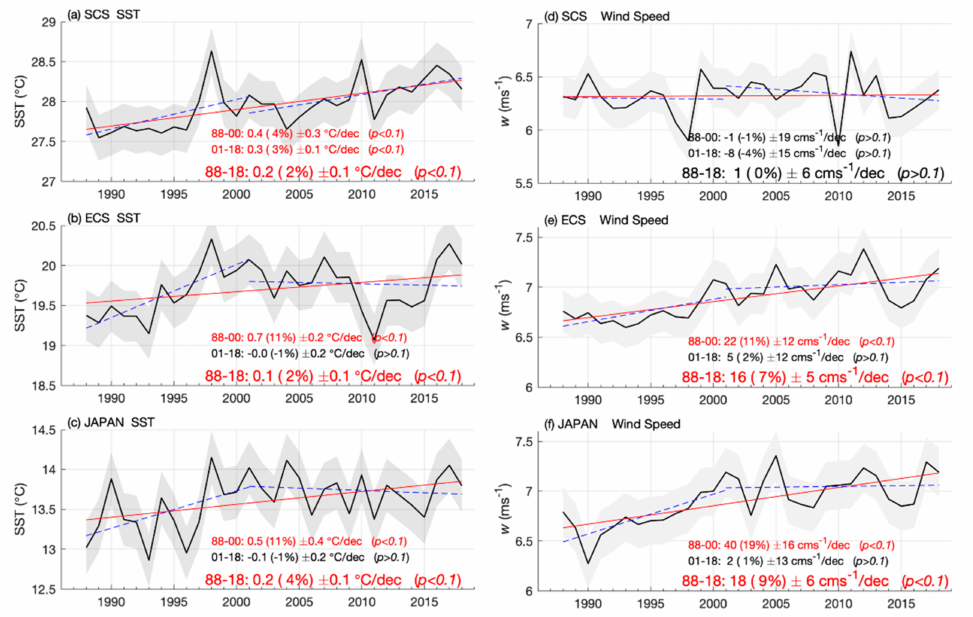
Figure 15. Basin-averaged annual time series (black line) of ( a – c ) SST and ( d – f ) wind speed for the East Asian marginal seas. ( a , d ) SCS: the South China Sea. ( b , e ) ECS: the East China Sea. ( c , f ) JAPAN: the Sea of Japan. The shaded area denotes one standard deviation of annual-mean variability. The red line denotes the linear trend over 1988–2018, and the dashed blue lines are the linear trends over 1988–2000 and 2001–2018, respectively. Linear trend estimates for the three periods are listed: 1988–2000 (top line), 2001–2018 (middle line), and 1988–2018 (bottom line), colored by red if the trend is statistically significant ( p < 0.1) or by black if the trend is statistically not significant ( p > 0.1). The value in the parentheses is the percentage